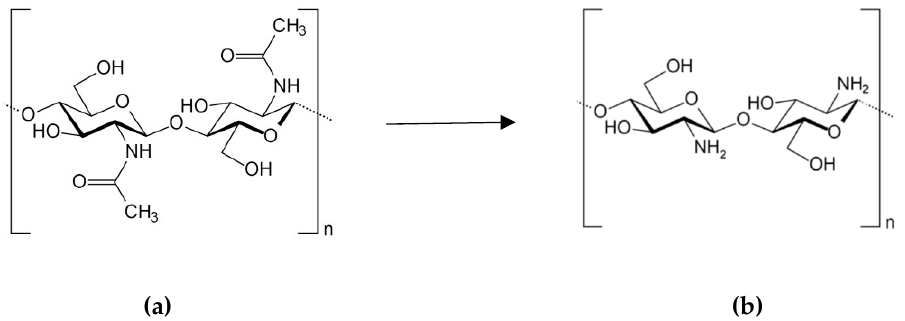
Figure 3. Transformation of chitin ( a ) to chitosan ( b ) by deacetylation.